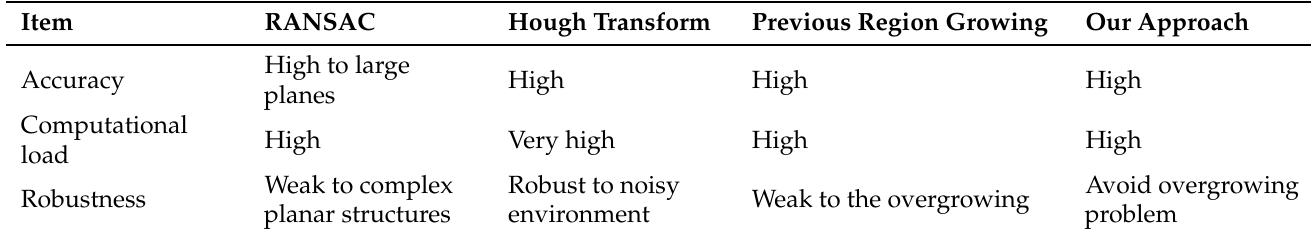
Table 3. Comparative